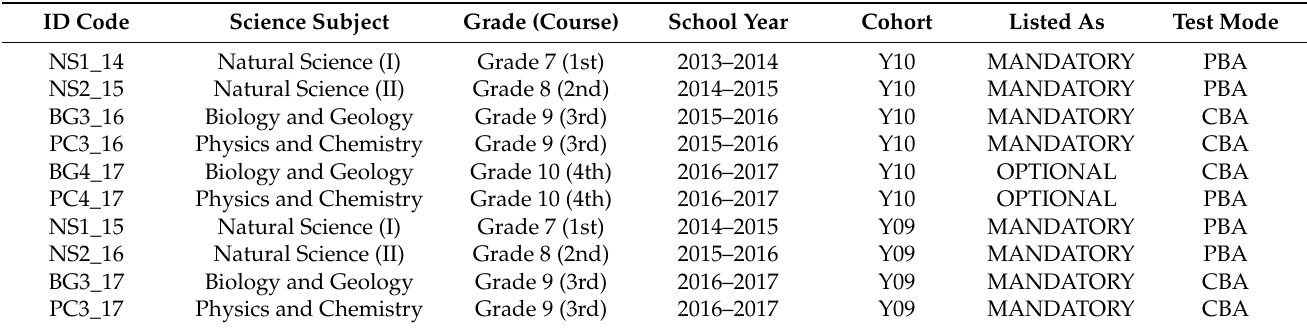
Table 1. A list of science subjects by course and school year taught to each cohort across secondary education, including the delivery mode of exams: CBAs or PBAs. ID